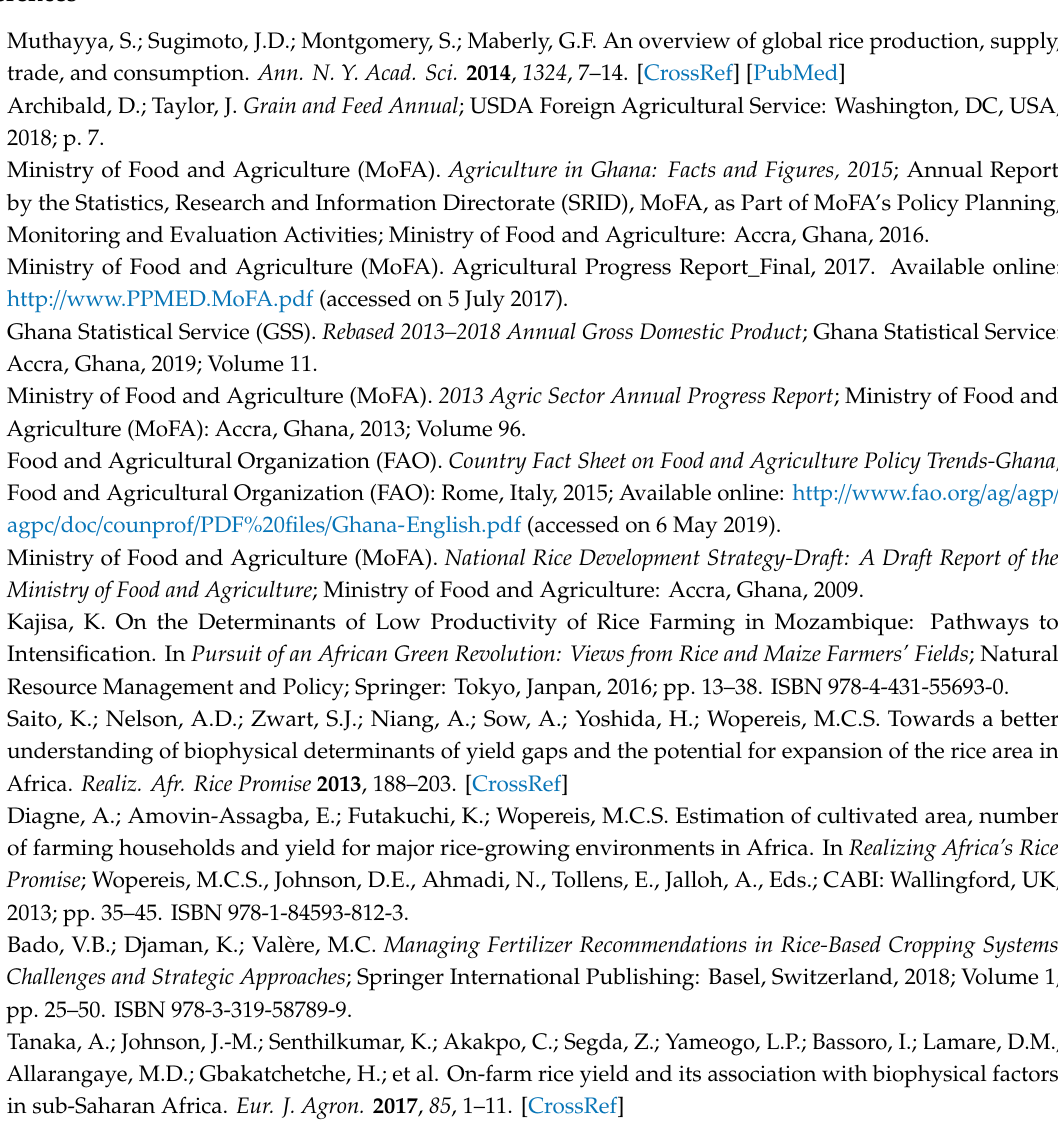
Table S2: The number of AMF species identified among six di ff erent regions in Ghana based on PCR–DGGE band profiles; Table S3: AMOSIM analysis of the e ff ects of rice varieties and sampling locations on AMF community structures in analyzed rice roots based on rarefied OTUs; Table S4: Mantel analysis based on Spearman’s rank correlation among each OTU and available phosphorus (AP) or carbon-to-nitrogen ratio (C /